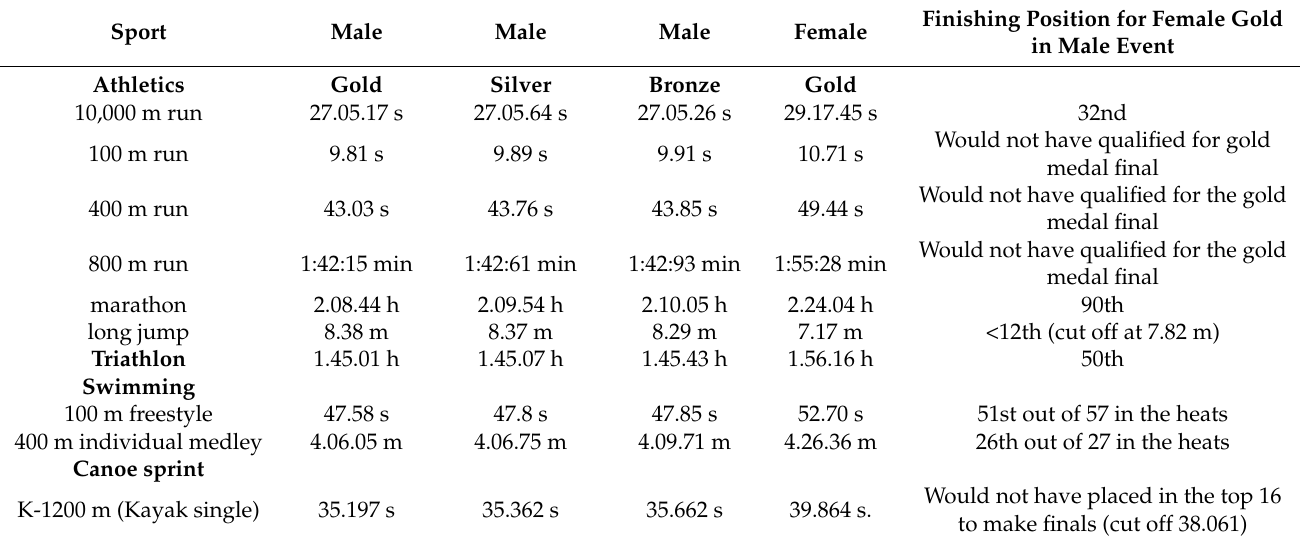
Table 1. Gold medal distances or times for selected sporting events recorded for males and females at the RIO Olympics